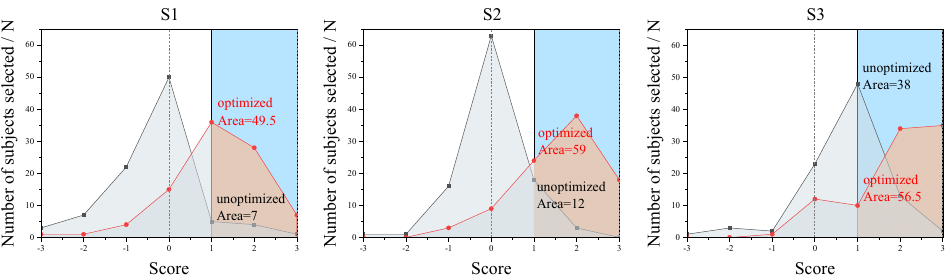
Figure 8. S1 − S3 before and after optimization.